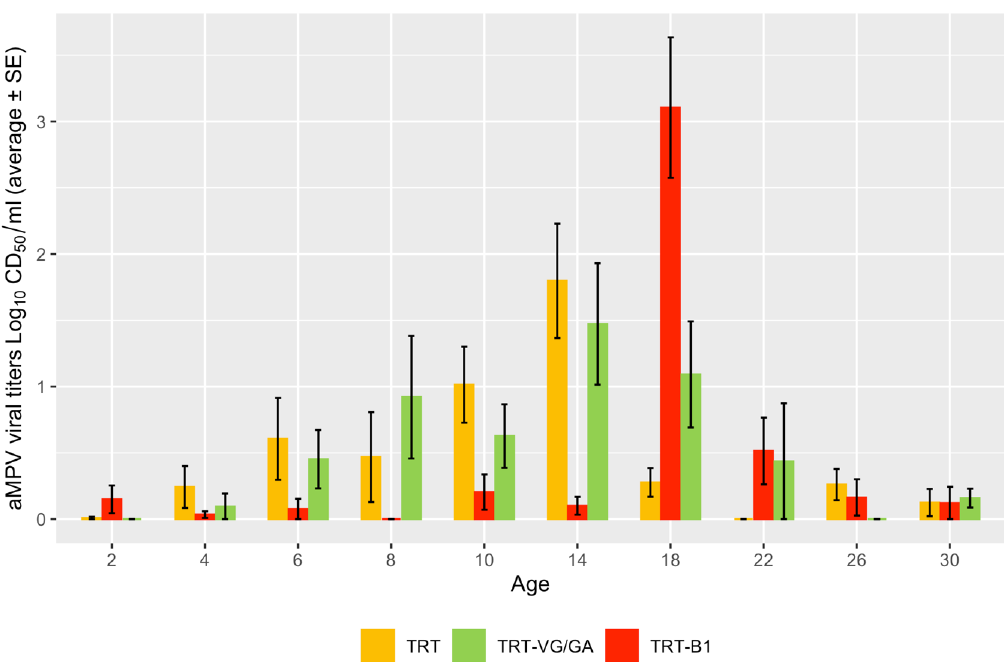
Figure 1. Mean aMPV vaccine load assessed longitudinally in oro-pharyngeal swabs using quantita- tive real-time RT-PCR.